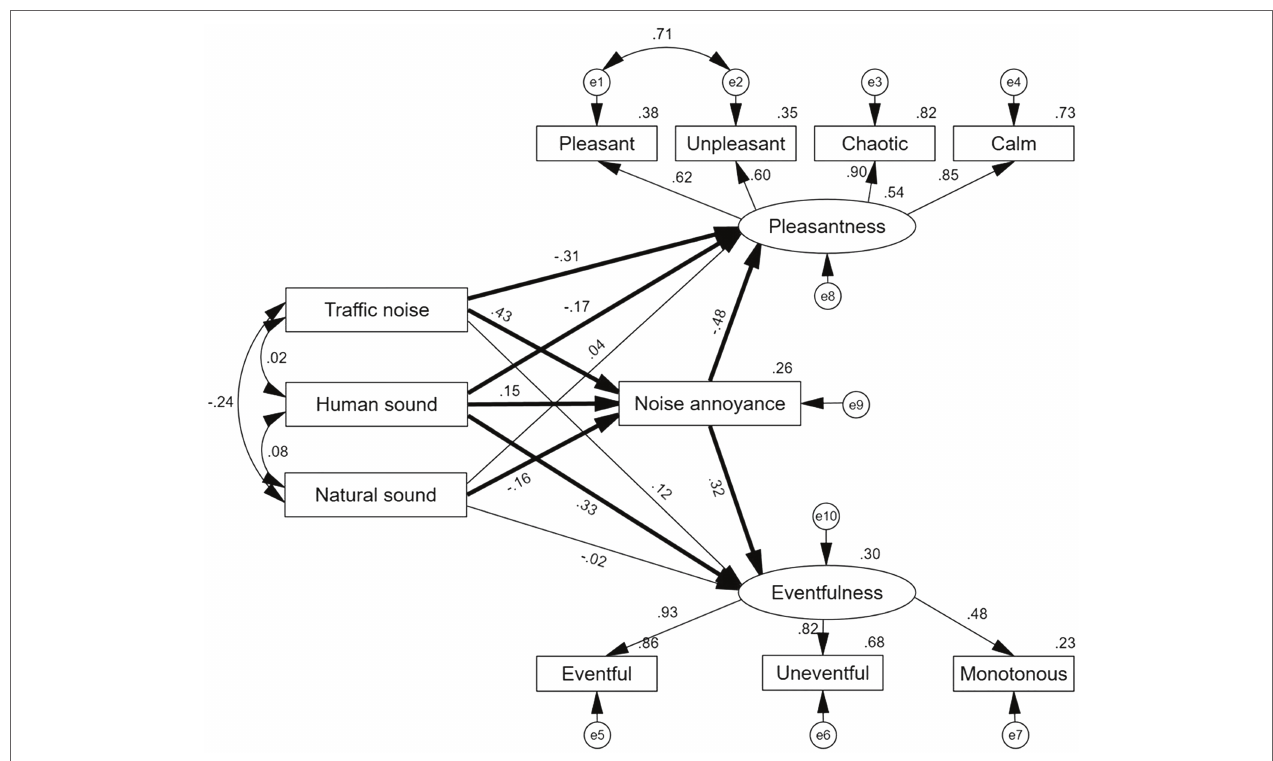
FIGURE 8 | Results of the multigroup analysis in the structural equation model (SEM) for the gated community ( N = 210). The presented coefficients are standardized. e, error term, residue term; bold line, significant; and thin line,